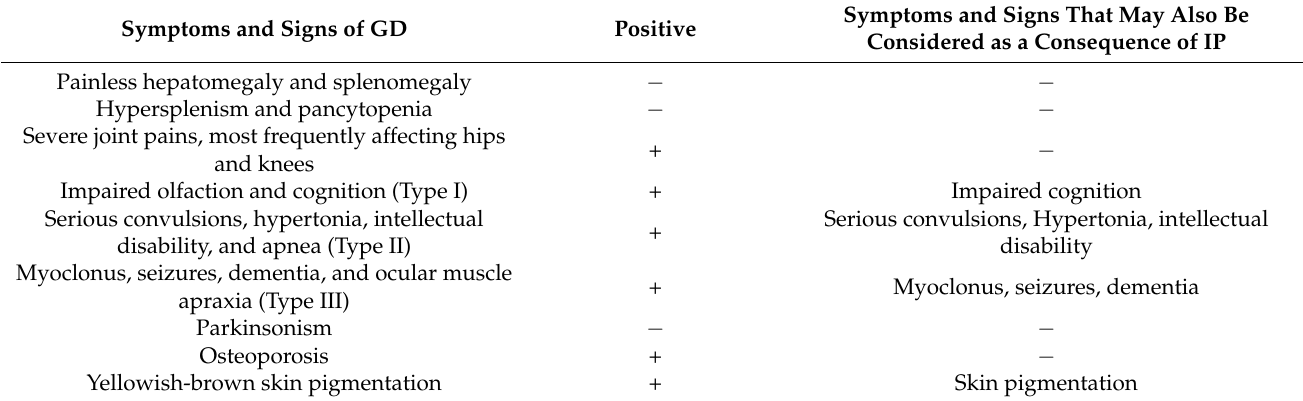
Table 3. The proband’s existing symptoms in comparison with the symptoms of Gaucher disease (GD) according to Stone et al.